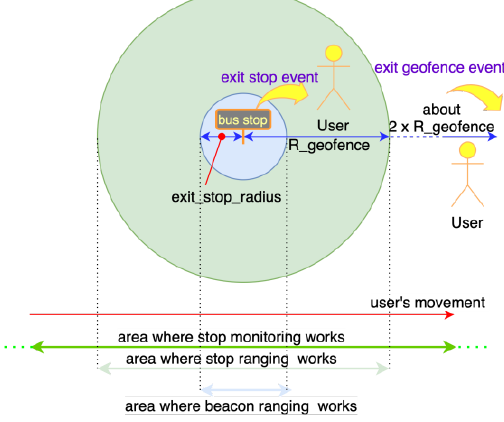
Figure 3. Detecting exit stop.